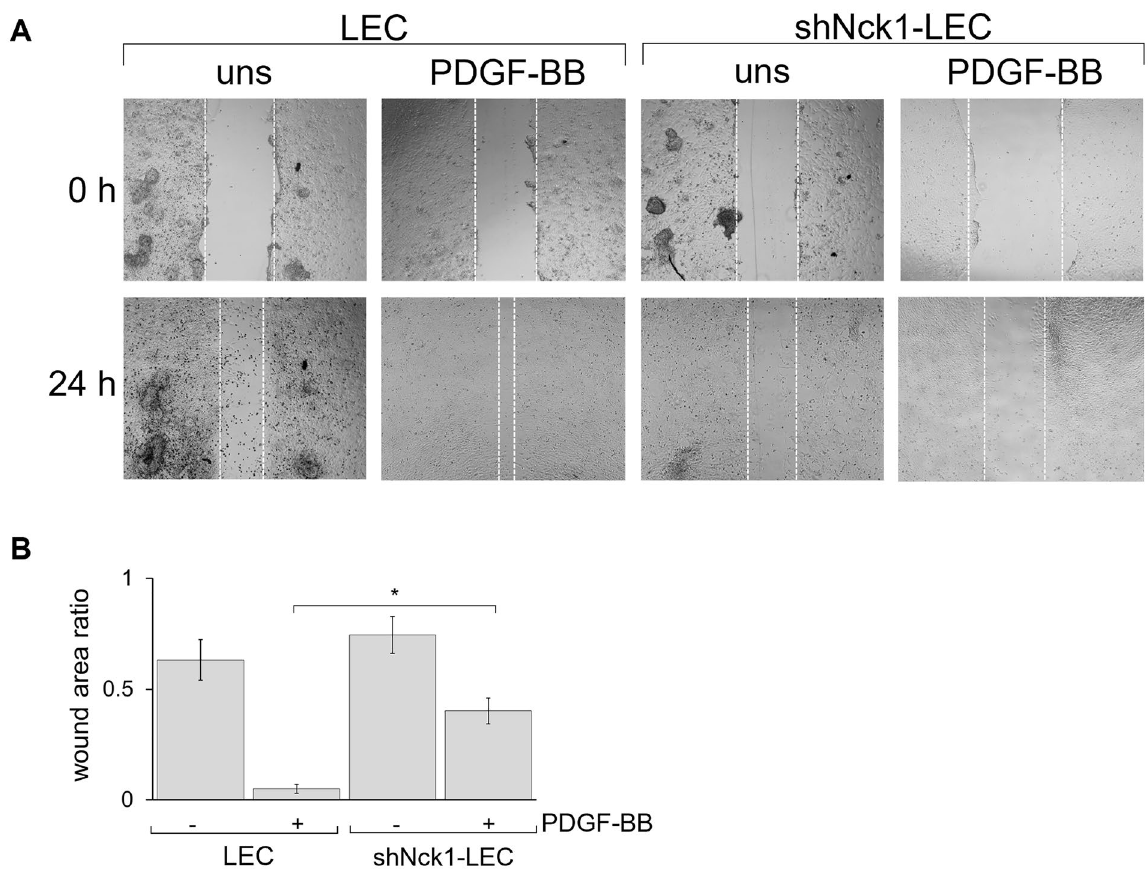
Figure 4. Knockdown of Nck1 inhibits PDGF-BB-induced LEC migration. A scratched wound was created in the absence or presence of 30 ng/ml PDGF-BB. The covered wound area quantification was acquired at 24 h. ( A ) Representative images of wound closure of LEC at 0 and 24 h. ( B ) Quantification of the wound area ratio is shown in graph representing the mean ± SEM. Data are representative of three independent experiments. **p <